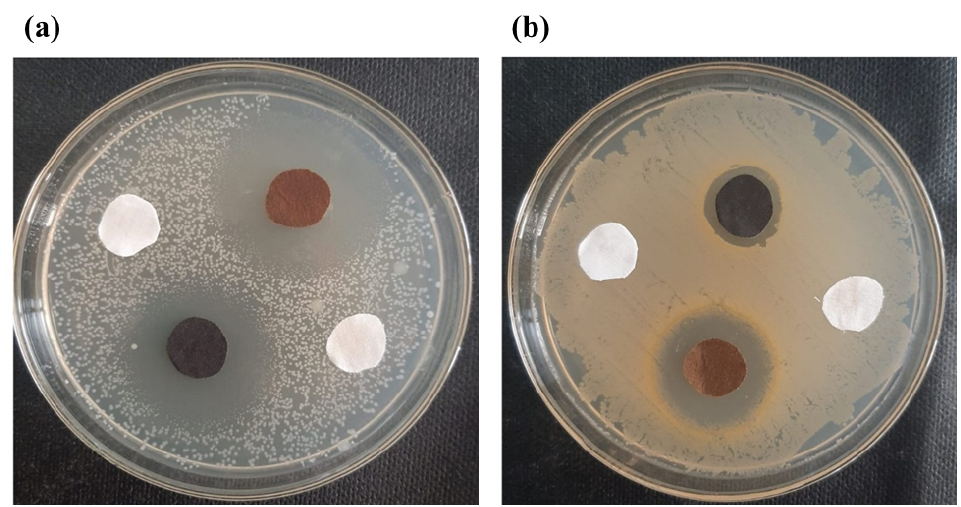
Figure 10. Inhibition zones against ( a ) S. aureus and ( b ) E. coli .